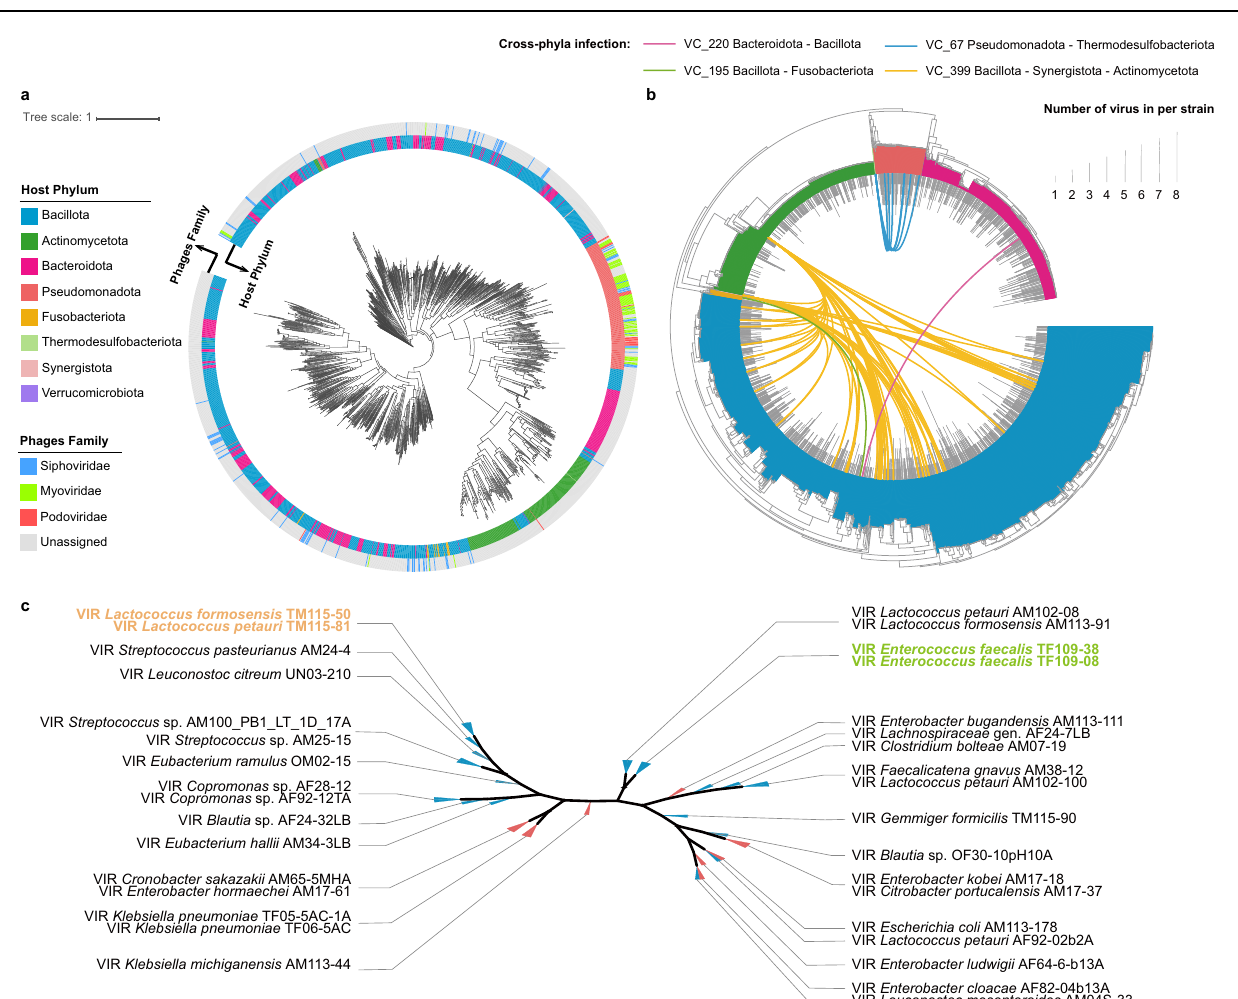
viruses the host harbors. Connections in four colors where each color represents one VC that can infect hosts in different phyla. c Phylogenetic analyses of PC_000663. Phages are named “ VIR_host species_host number ” . Leaf colors indi- cate to which phylum phages